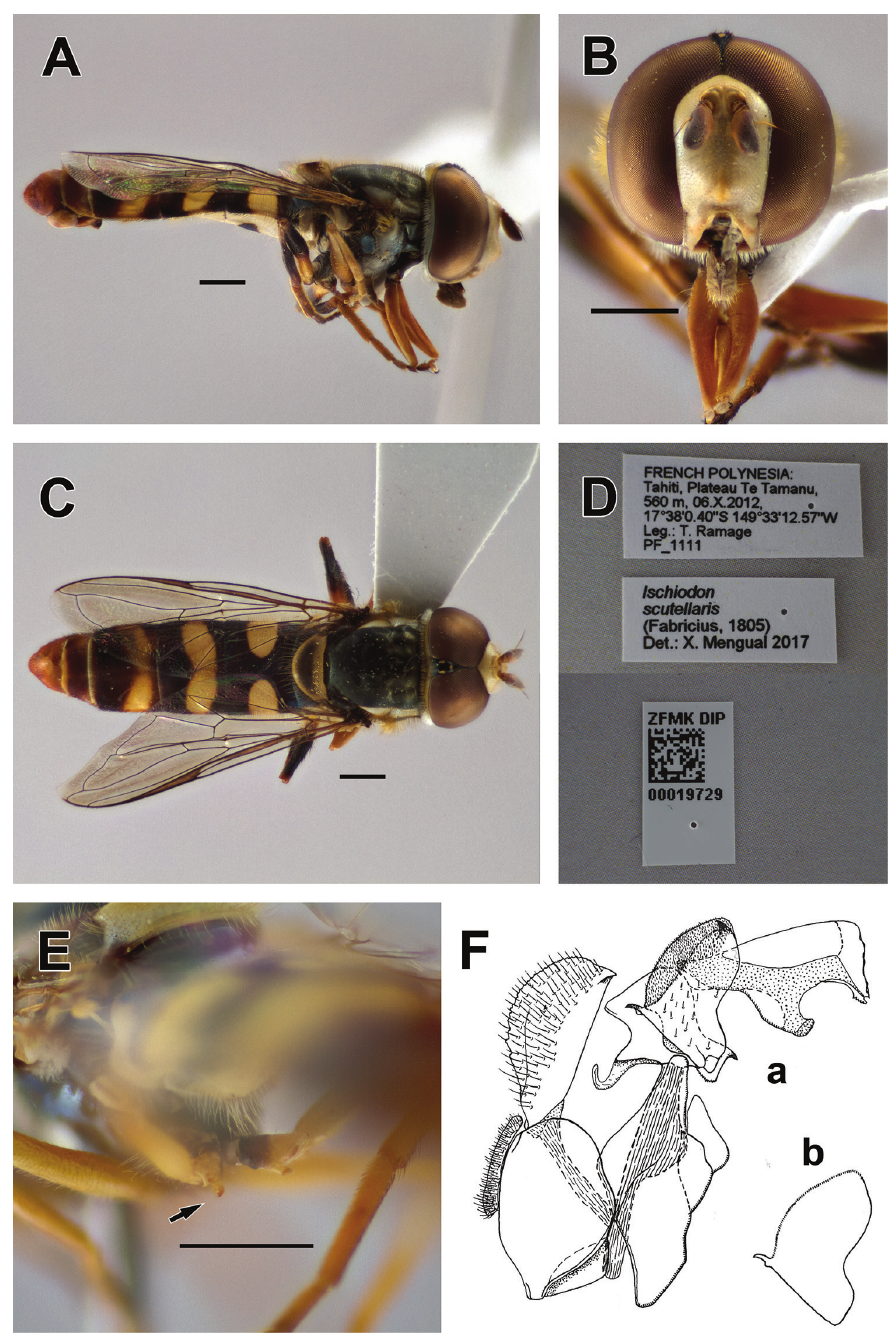
Figure 6. Ischiodon scutellaris (Fabricius), male ZFMK-DIP-00019729: A Habitus, lateral view B Fron- tal view C Habitus, dorsal view D Labels E Metacoxa and metatrochanter, posterolateral view F Male genitalia: a lateral view b postgonite, outline only (from Vockeroth 1969). Scale bars: 1